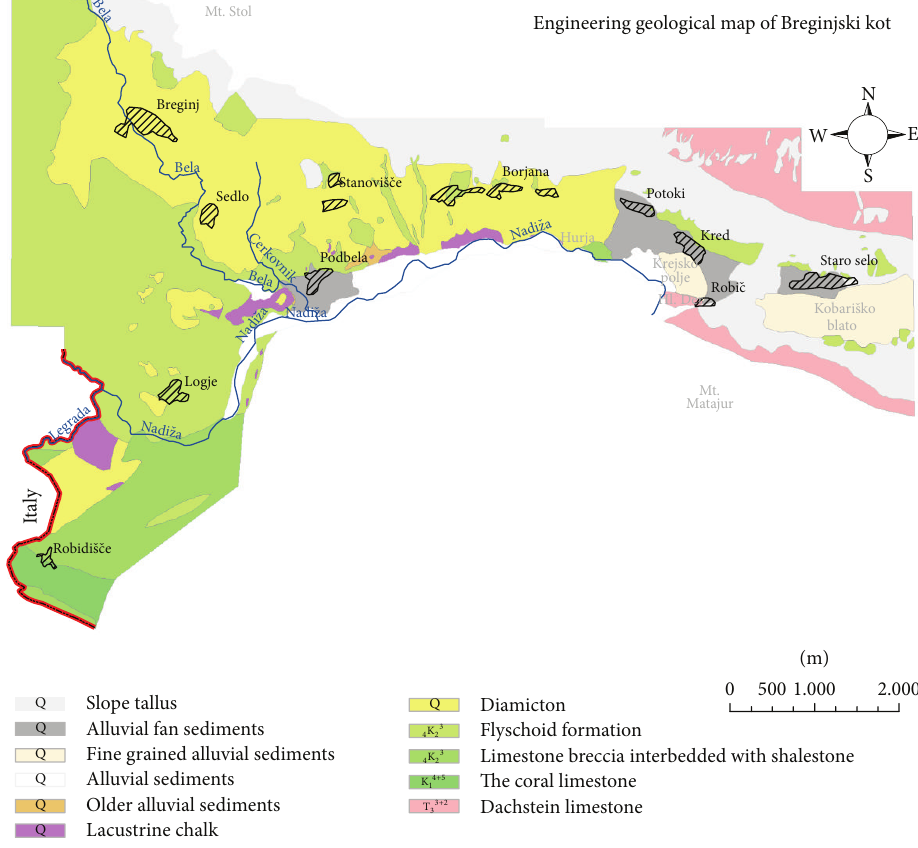
Figure 4: Engineering geological map of Breginjski